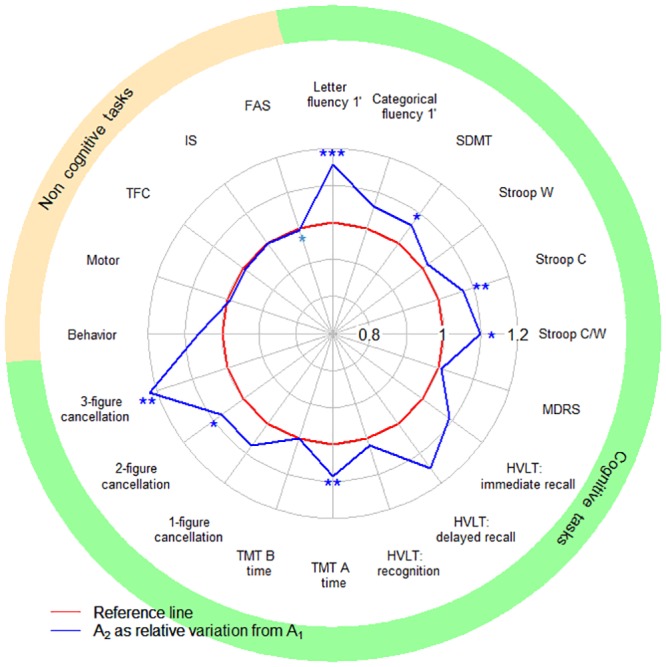
Impact of the retest effect in the MIG-HD cohort.SDMT: Symbol Digit Modalities Test; Stroop C, W and C/W: Stroop color, word and color/word interference; MDRS: Mattis Dementia Rating Scale; TMT A, B: Trail-Making Test A and B; TFC: Total Functional Capacity; IS: Independence Scale; FAS: Functional Assessment Scale. The red curve represents the baseline (reference score A1) and the blue curve shows the mean relative score one month later (A2). The portion of the blue curve beyond the red curve indicates performance improvement between A1 and A2. Paired t-tests, significance: * P<0.05, ** P<0.01, *** P<0.001.